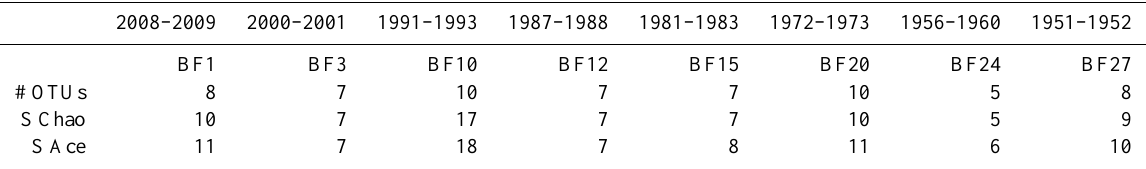
Table 3. Total number of OTUs and richness estimators (SChao and SAce) obtained for each period (i.e. for each of the 8 sediment layers selected between 1951 and 2009) from 16S rRNA gene sequences ( ∼ 1100bp alignment) presented in phylogenetic tree (Fig. 4).